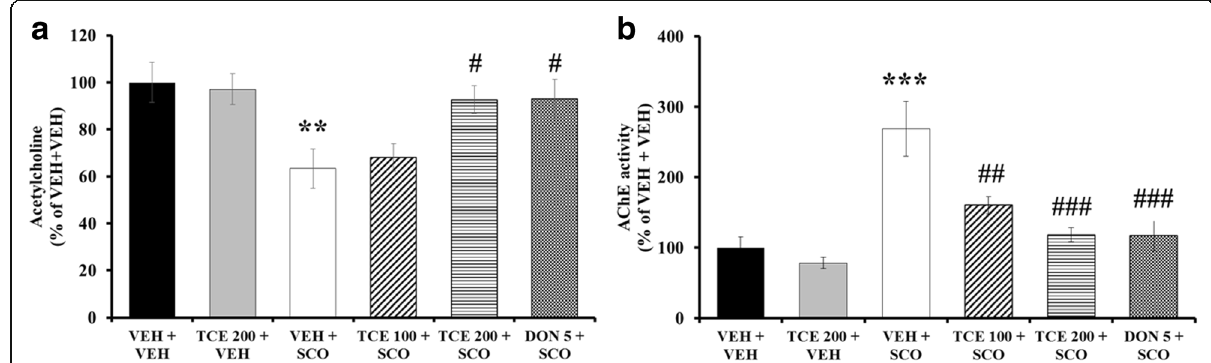
Fig. 3 Effect of TCE on hippocampal ACh levels and AChE activity in the scopolamine-induced model. a The level of ACh in hippocampal tissue is shown ( n =3 per group). b Hippocampal AChE levels are presented ( n =5 per group). Bar graph is expressed as a percentage of VEH +VEH control. The data are expressed as the means ± S.E.M. * p <0.05, *** p <0.001 compared with VEH+VEH; # p <0.05, ## p <0.01, ### p <0.001 compared with VEH